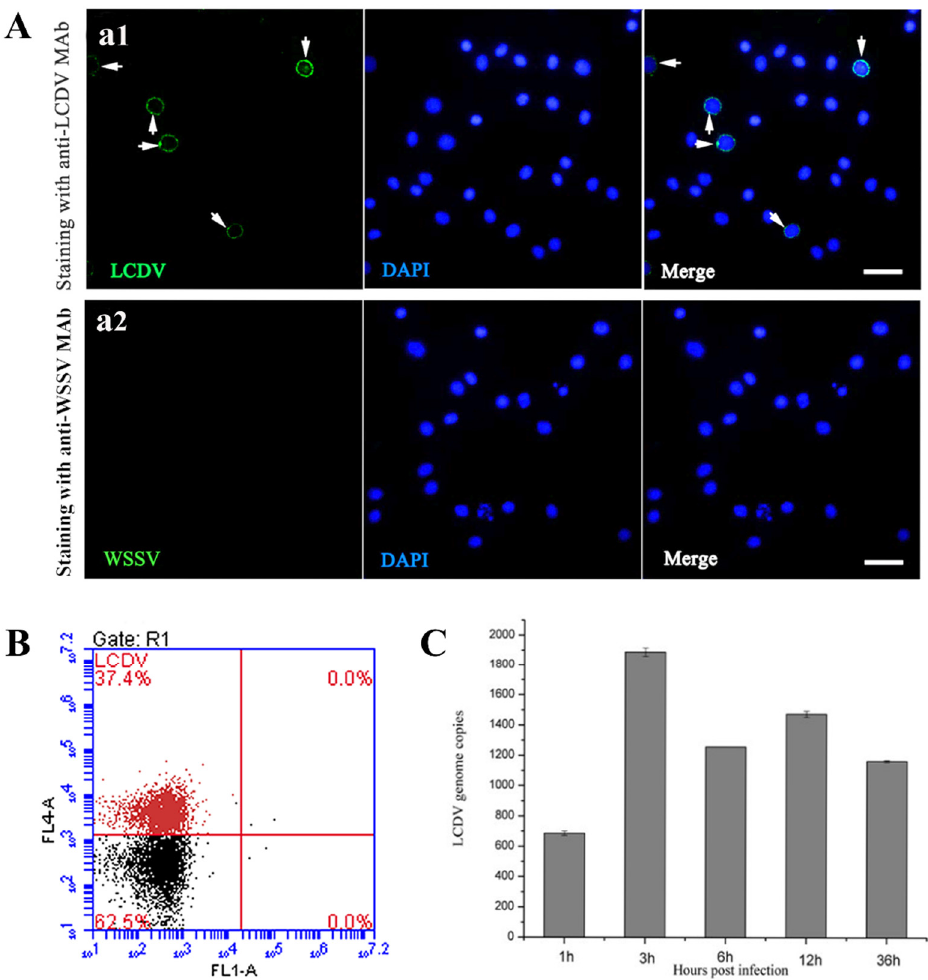
Figure 1. Detection of LCDV in peripheral blood leukocytes (PBLs) of LCDV-infected flounder in vivo. ( A ) Anti-LCDV MAb staining of the isolated PBLs, showing positive green signals in some PBLs (white arrows) ( a1 ); Anti-WSSV MAb staining of PBLs presented no green signals as negative control ( a2 ). ( B ) Flow cytometry analysis indicated the percentage of LCDV + cells in PBLs by scatter diagram. ( C ) The LCDV copy numbers in PBLs of LCDV-infected flounder at different time points. Cell nuclei were counterstained in blue by DAPI. Scale bar = 10 µ m. Error bars represent standard deviations (SD, n = 3).